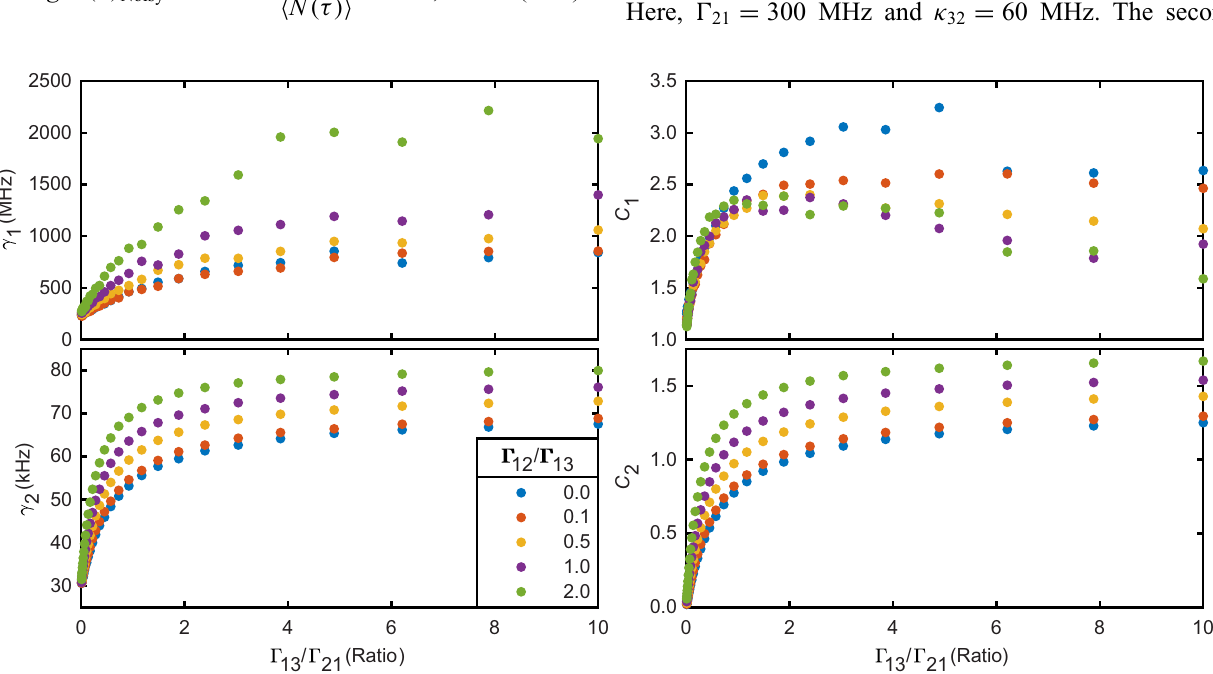
FIG. 13. Simulation of optical dynamics for different (cid:8) 12 /(cid:8) 13 . Antibunching and bunching parameters resulting from simulation of the model discussed in the main text for (cid:8) 12 as a factor of (cid:8) 13 for spontaneous transition. Simultaneous excitation to level 2 and level 3 takes place at different rates, which is a ratio of the two